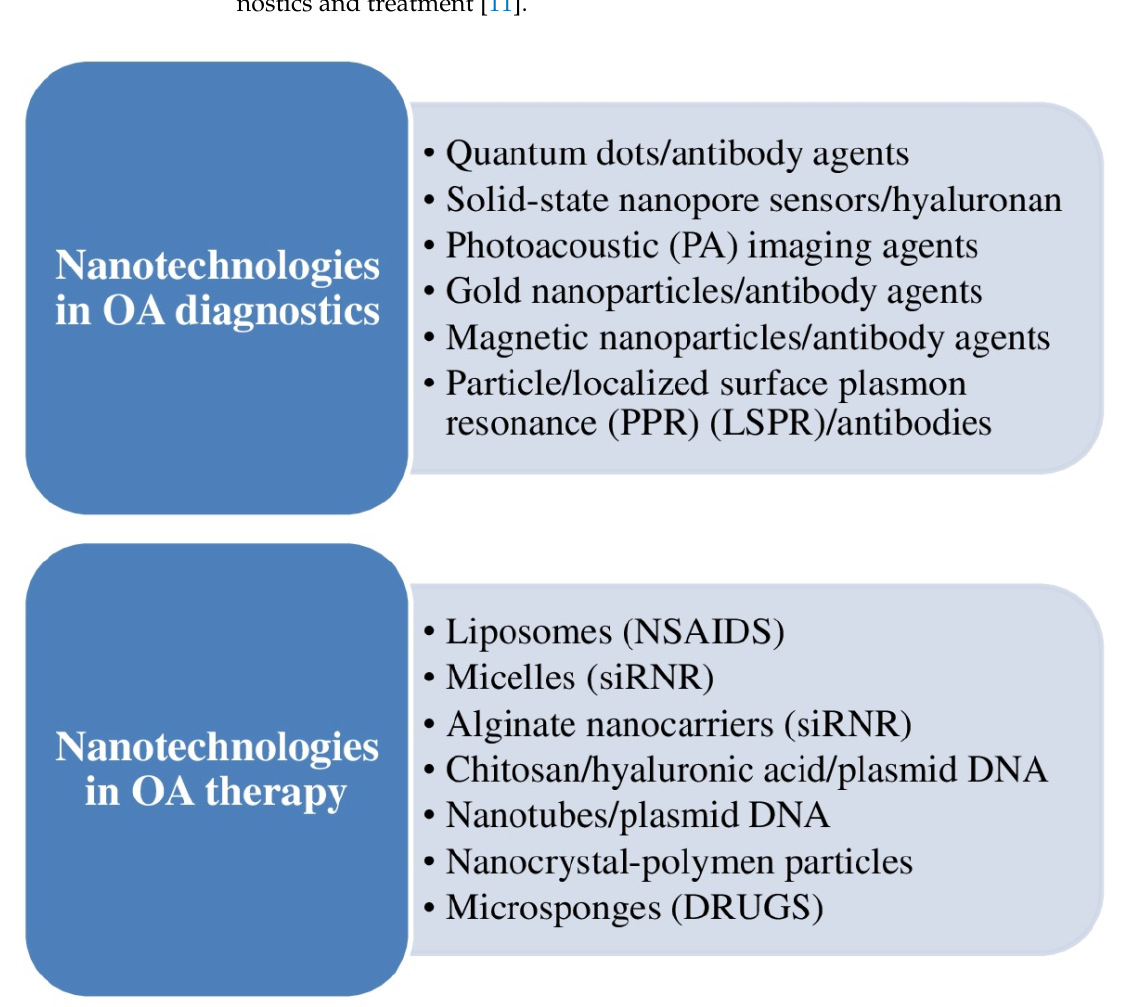
Figure 5. Outline of nanotechnology-based uses in the diagnosis and treatment of osteoarthritis (OA).